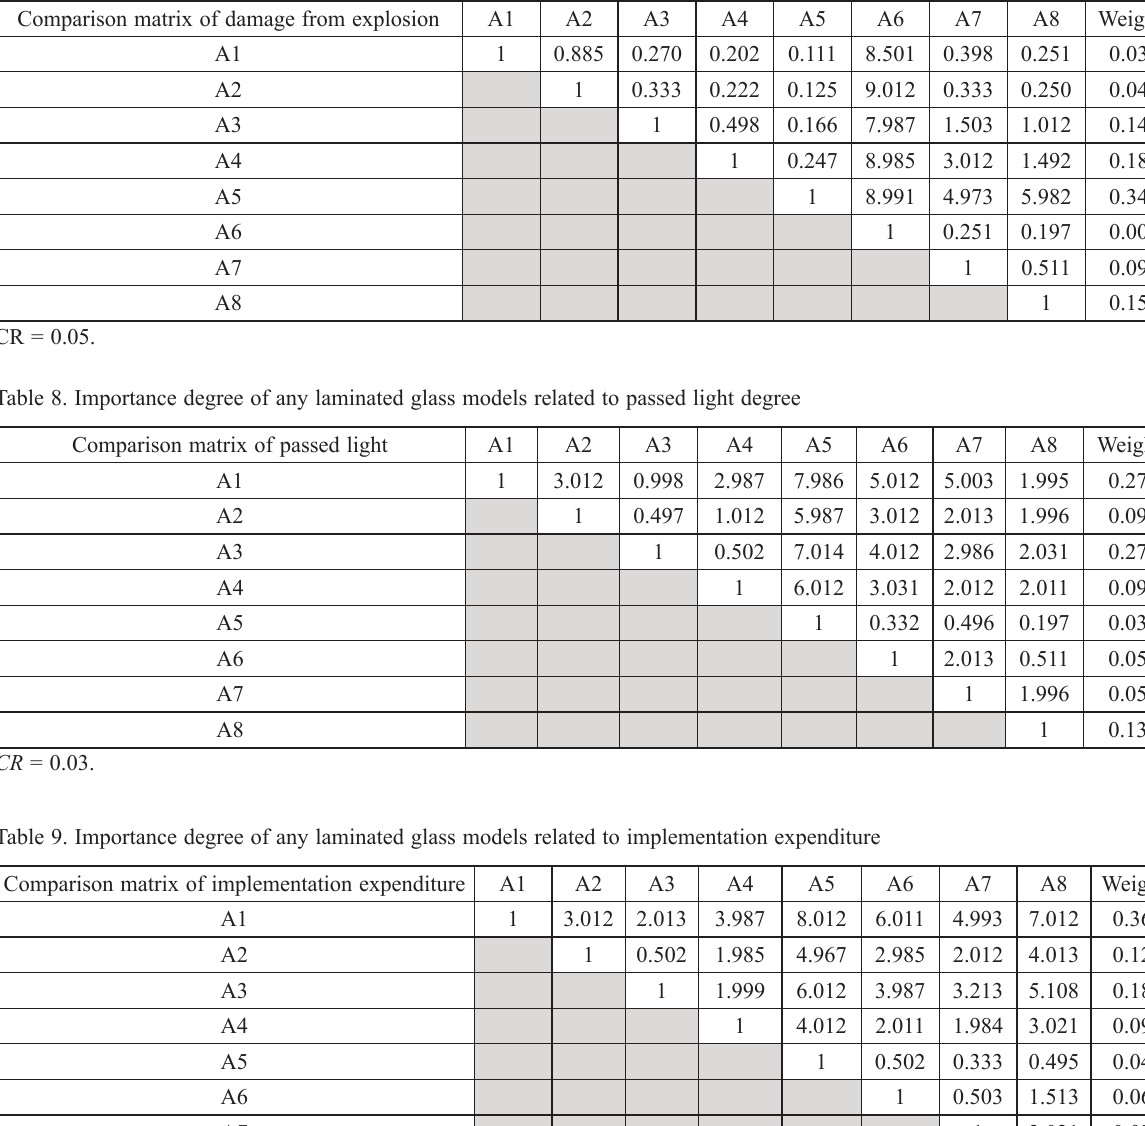
Table 7. Importance degree of any laminated glass models related to damage from explosion Comparison matrix of damage from explosion